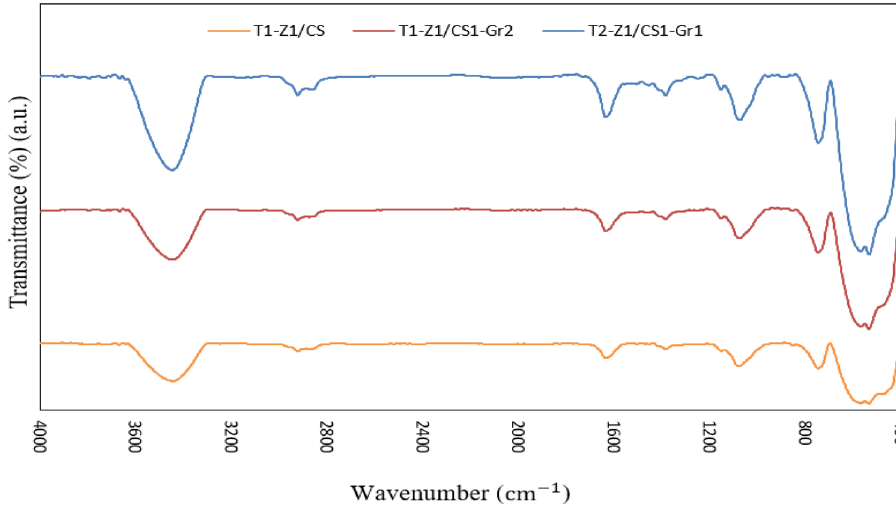
Figure 2. FTIR spectra for nanocomposites in this study.